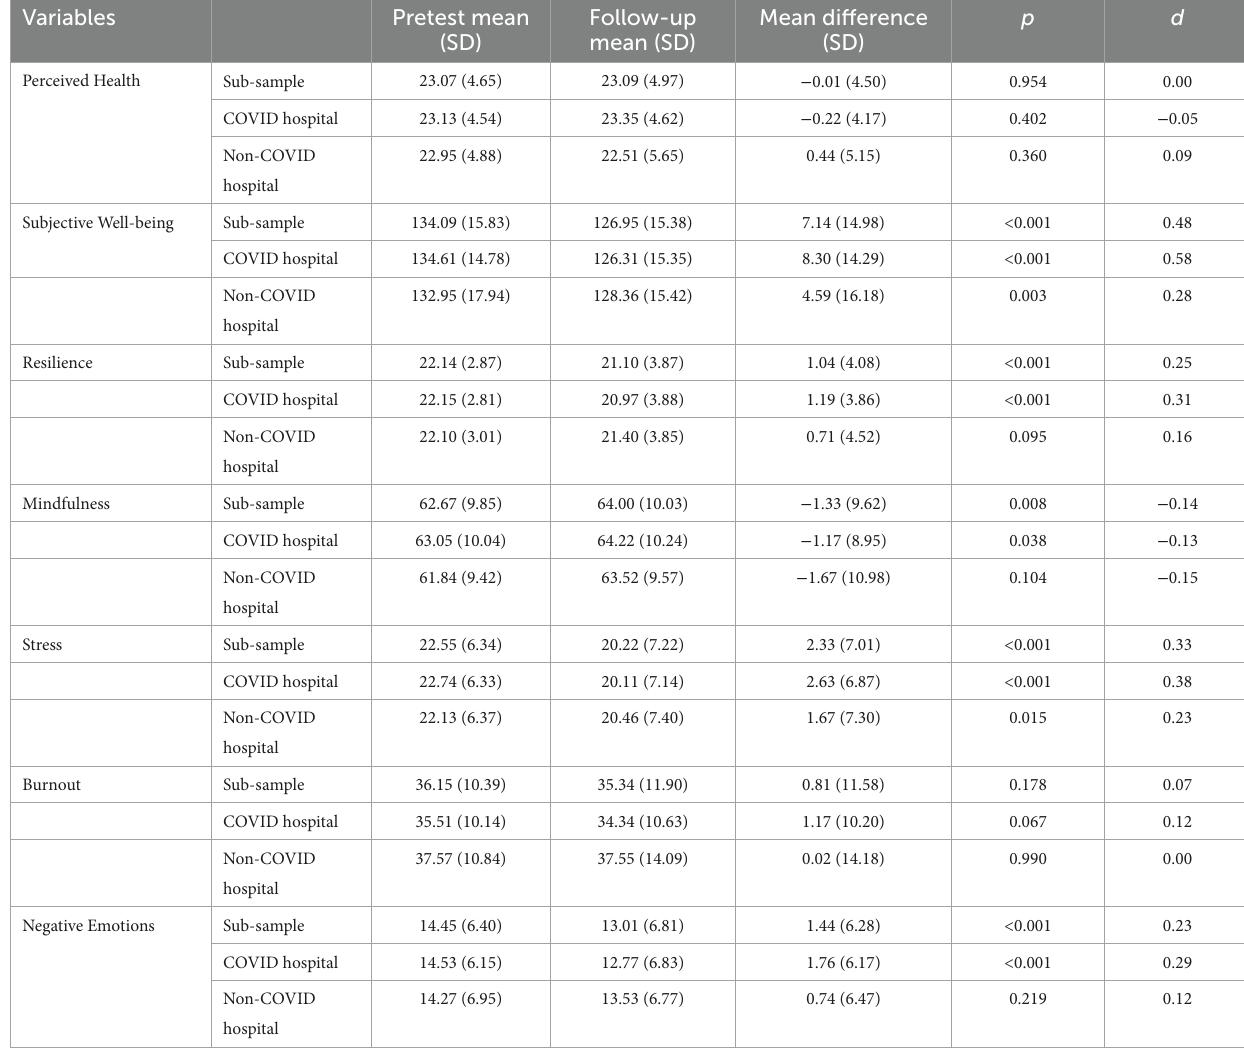
TABLE 3 Mean scores and mean difference for perceived health, subjective well-being, resilience, mindfulness, stress, burnout and negative emotions at pretest and 6 months follow-up for a sub-sample of nurses who completed both timepoint measures and divided by hospitals.